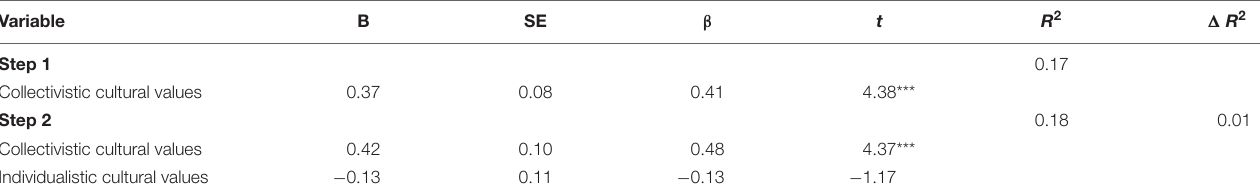
TABLE 5 | Hierarchical regression of Mainland Chinese mothers’ child-rearing